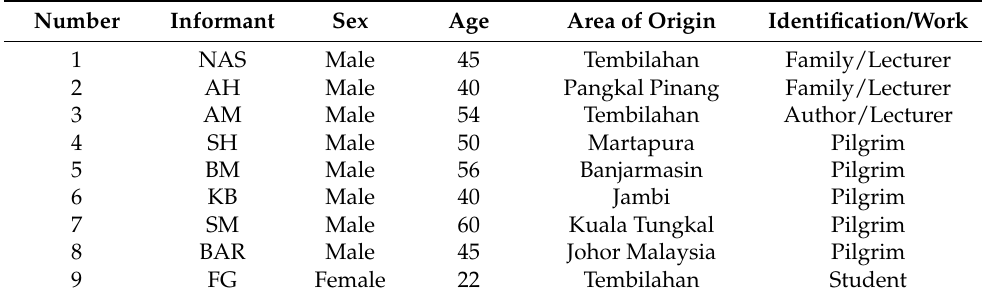
Table 1. Research